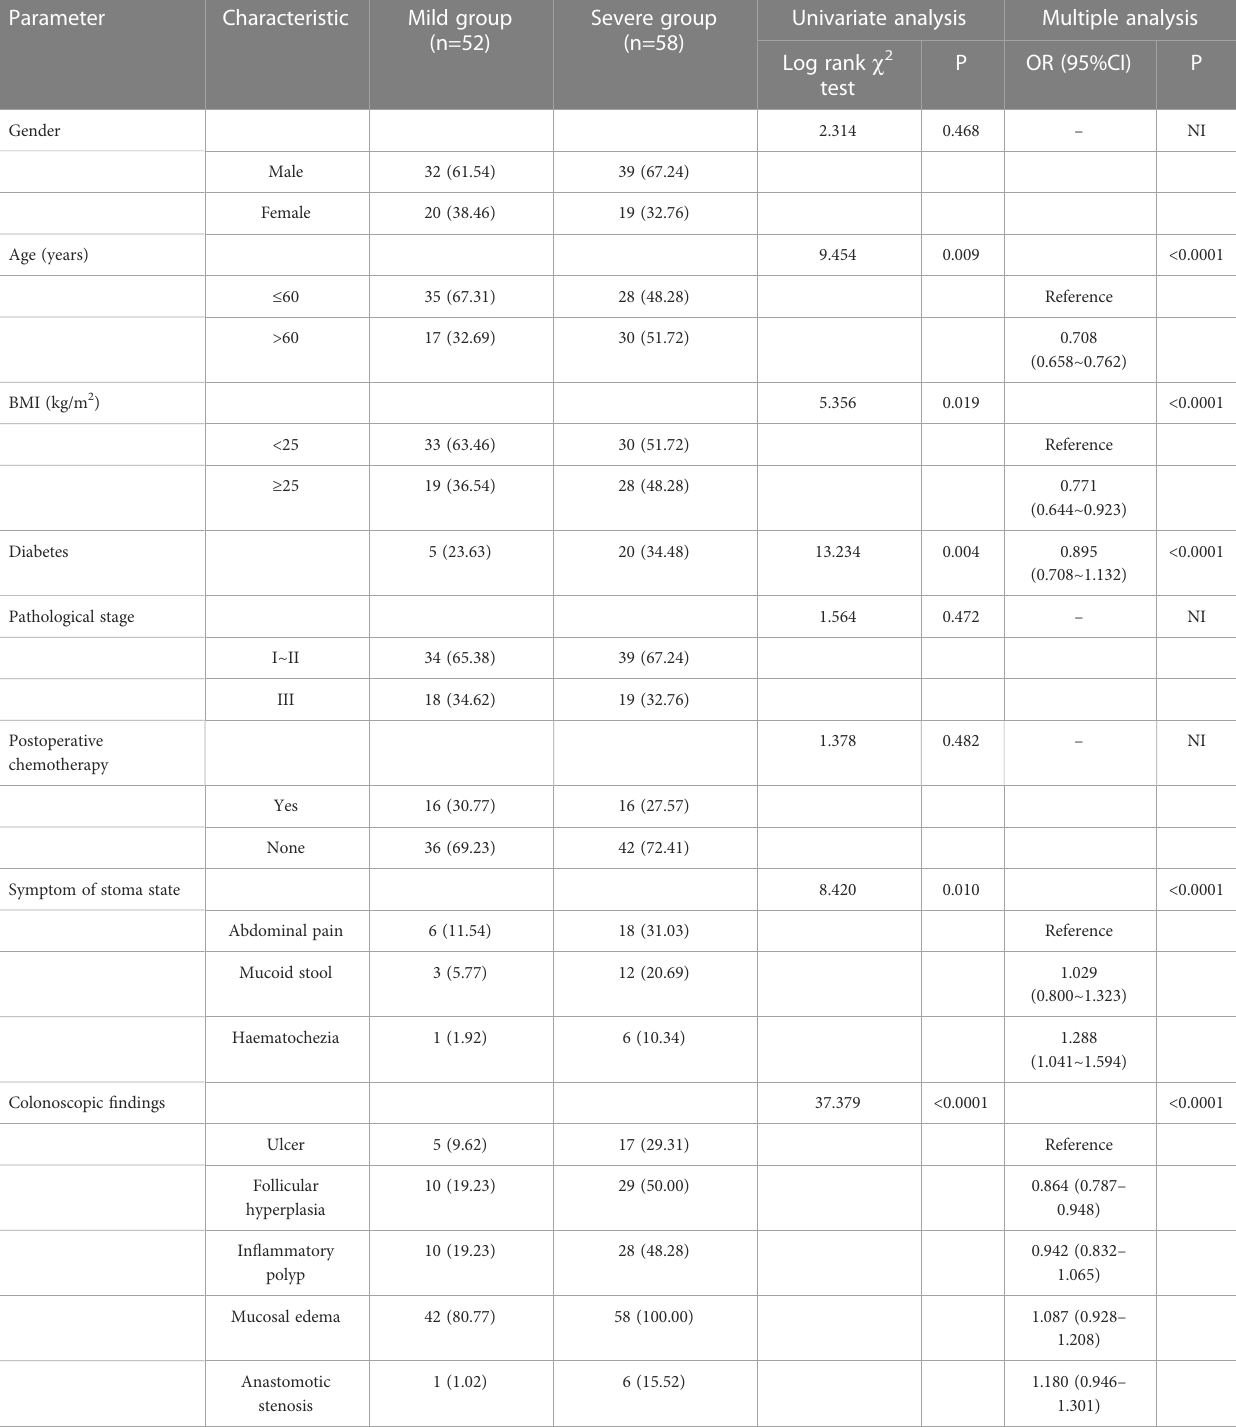
TABLE 1 Univariate and multiple analysis of clinical data for two groups in stoma status